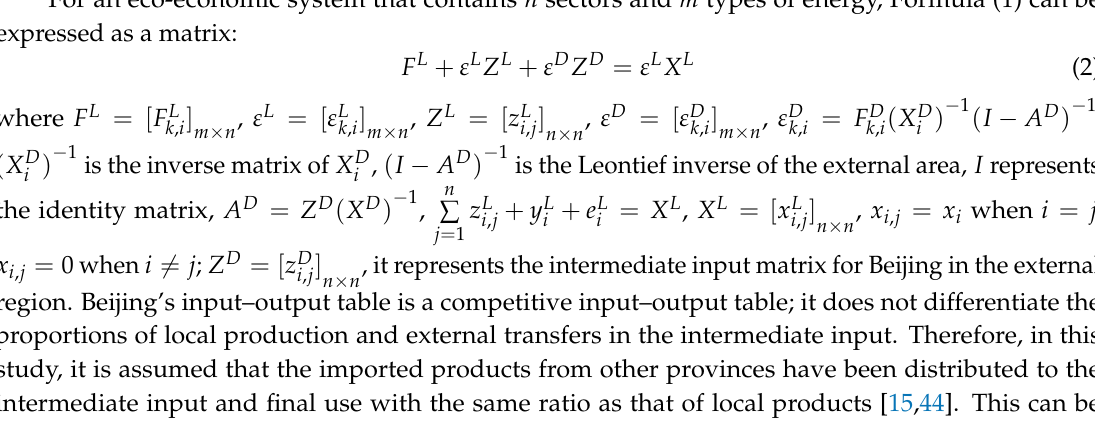
Figure 1. The embodied energy balance of sector i in an economic system (with the k -th type of energy).